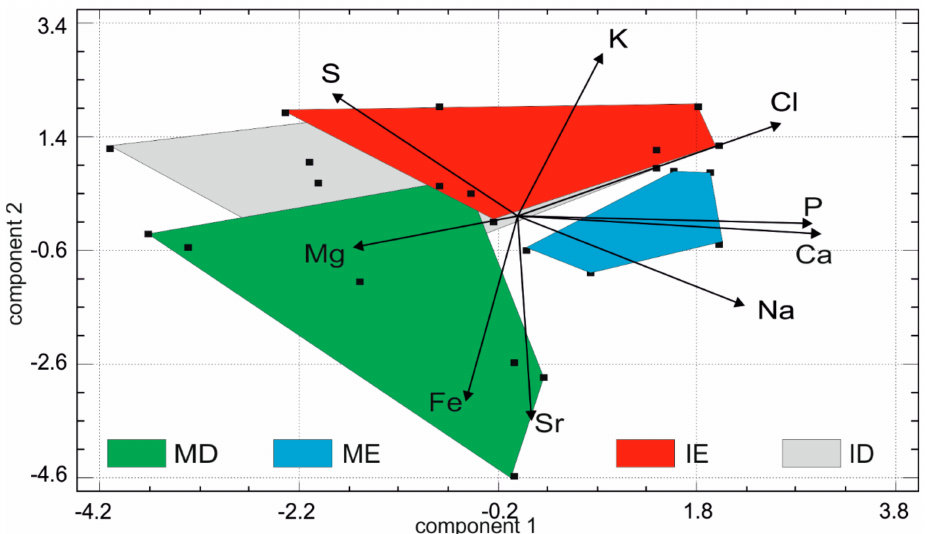
Figure 10. Principal component plot based on the chemical compositions of the digested teeth. ME: molar enamel, IE: incisor enamel, MD: molar dentine, ID: incisor